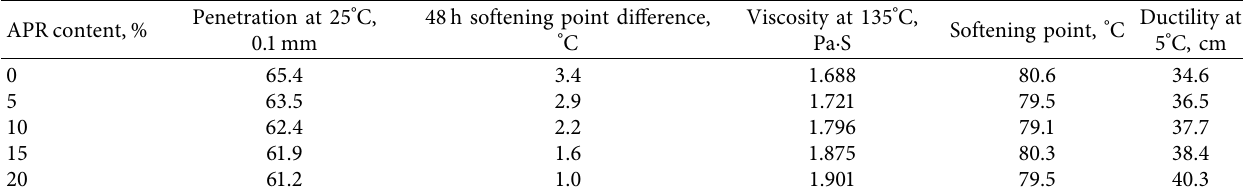
Figure 18: The maximum amplitude of SBS modified asphalt with different APR contents. Table 6: Technical performance of SBS modified asphalt with different contents of